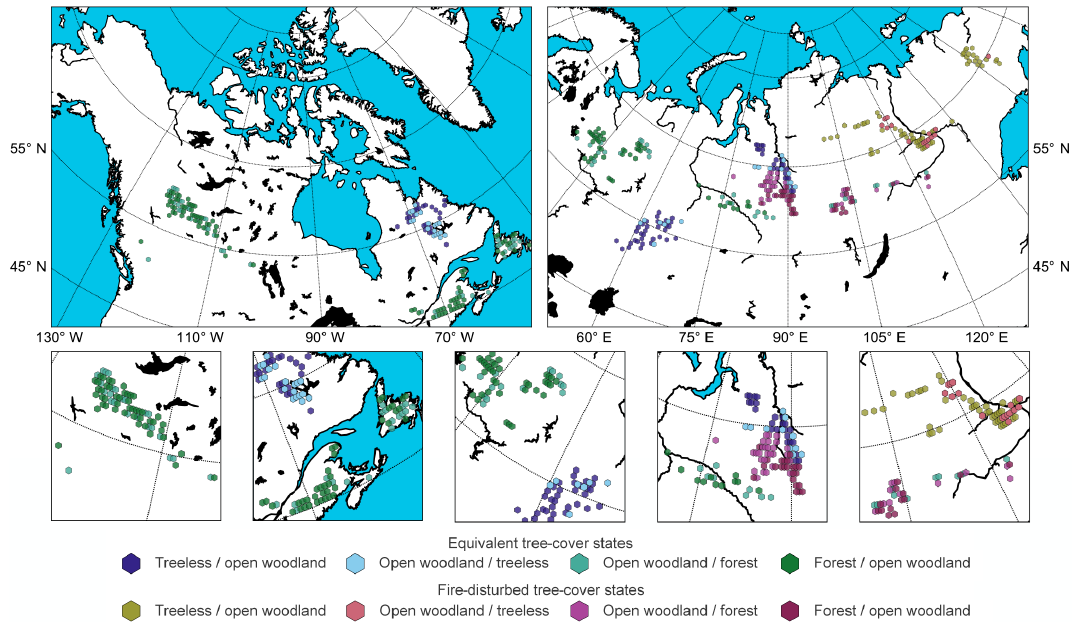
Figure 3. Possible alternative tree-cover states over North America (left) and North Eurasia (right). The bottom five panels represent a close- up of the areas of interest ordered from west to east. Legend to be interpreted as follows: for every entry in the legend, the first name refers to the observed vegetation state in a specific grid cell, the second name corresponds to the possible alternative state found elsewhere under the same environmental conditions. Fire-disturbed tree-cover states are only present eastern North Eurasia.